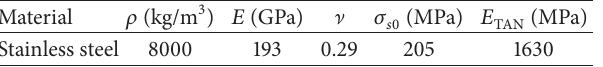
Table 4: Mechanical properties of material.